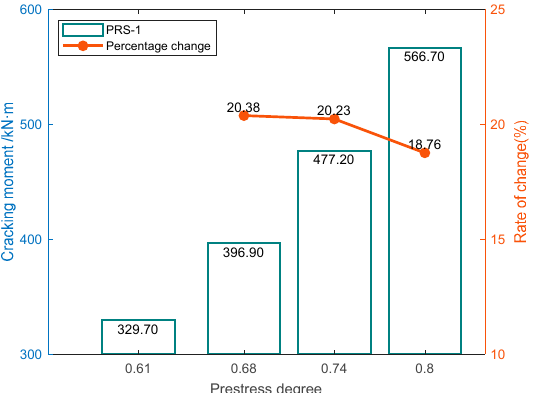
Figure 17. Effect of prestressed steel strand on ultimate bending moment.